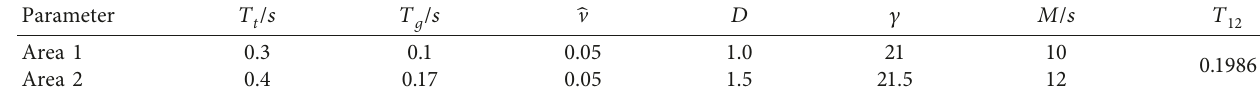
Table 2: Parameters of two-area LFC